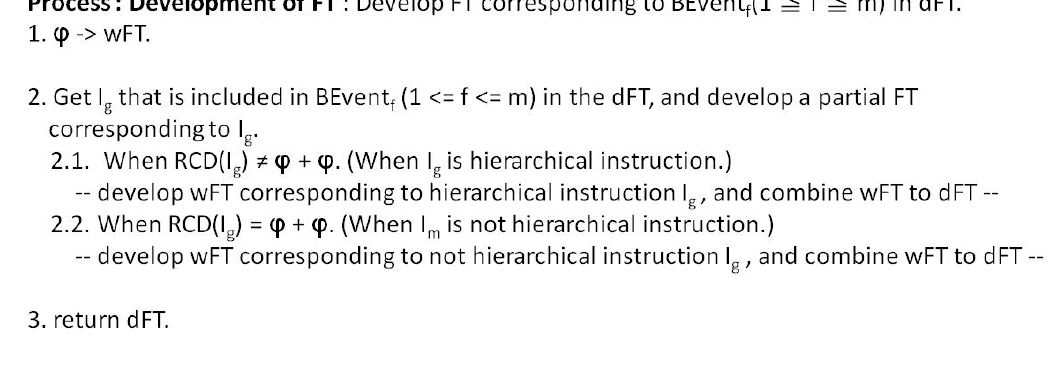
Figure 13. FT development rules -overview.